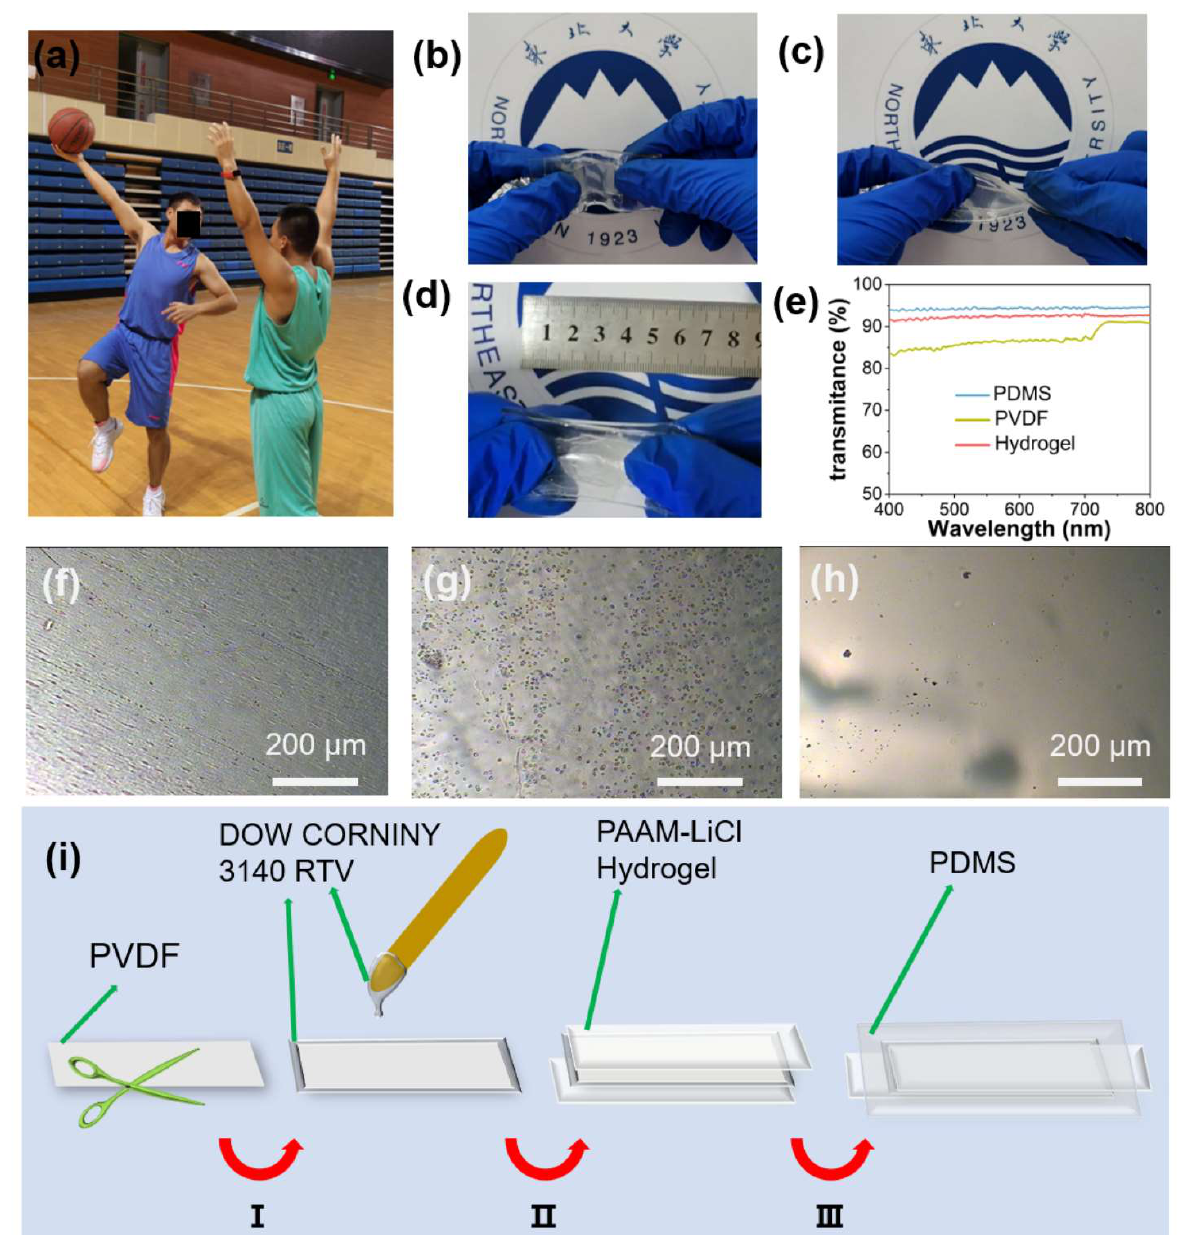
Figure 1. ( a ) The actual application scenarios of TSB-PENG. ( b – d ) The bend, twist and stretch state of TSB-PENG ( e ) The transmittance of PVDF film, PAAM-LiCl hydrogel, PDMS, and TSB-PENG. ( f – h ) The optical microscopic image of PVDF film, PAAM-LiCl hydrogel, and PDMS. ( i ) Schematic diagram of manufacturing process of TSB-PENG.